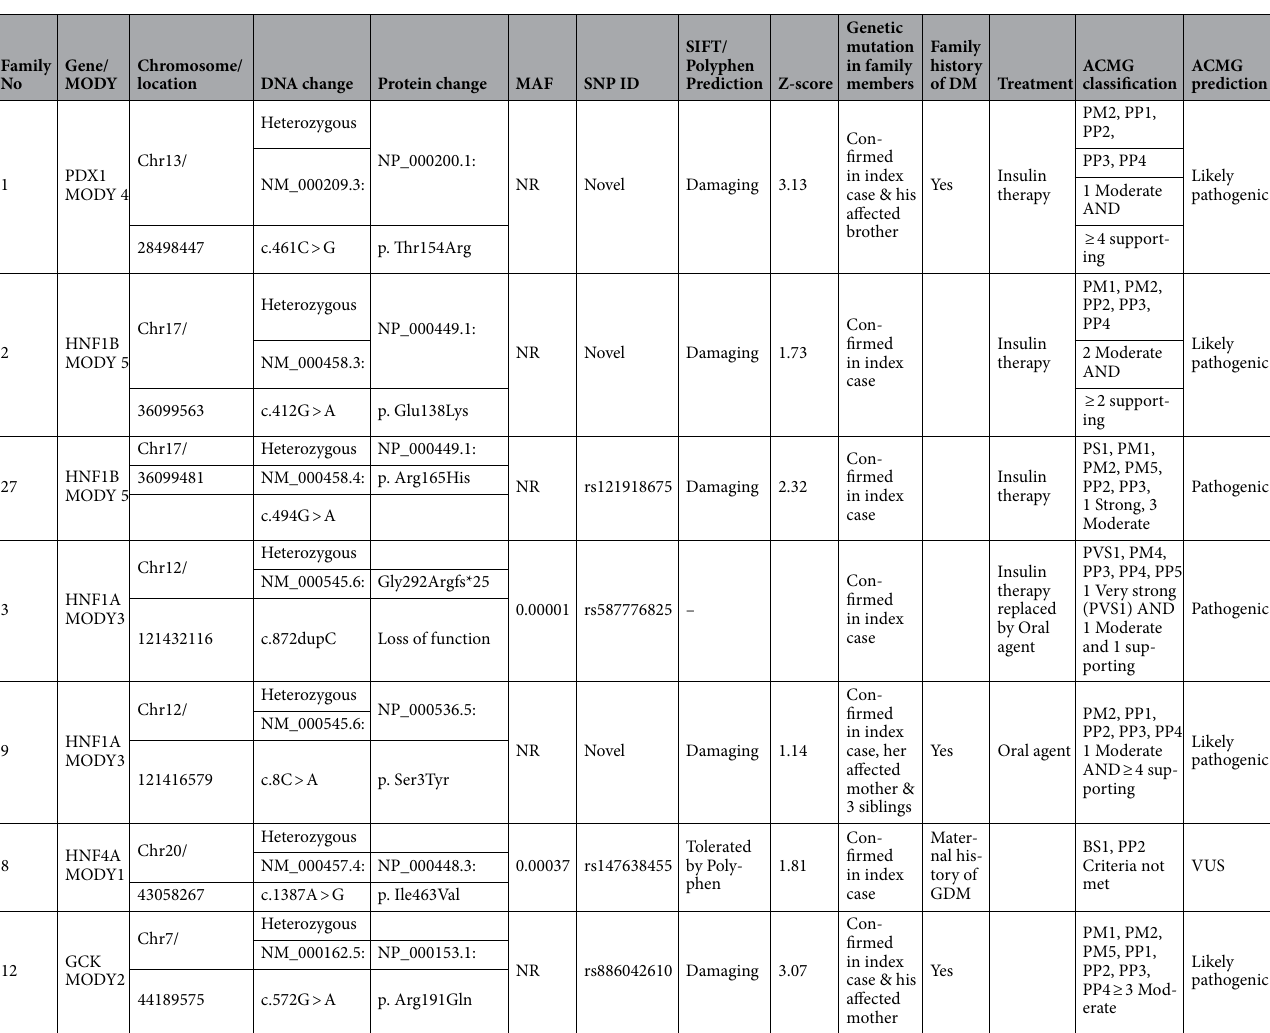
(Table 2). The HNF1B exon 4 p.E138K variant, in family 2, was detected in a Kuwaiti boy diagnosed shortly after birth with chronic renal failure due to bilateral cystic kidney disease. After renal transplantation at the age of 3 years, he started to show intermittent symptomatic hyperglycemia at the age of 9 years. His hyperglycemia became persistent, requiring insulin therapy at the age of 10 years. Unfortunately, other family members refused to consent for genetic testing. Three variants within six amino acid positions of the variant p.E138K have been shown to be pathogenic, while none are benign. The second HNF1B variant, c.494G > A, was identified in 6 years